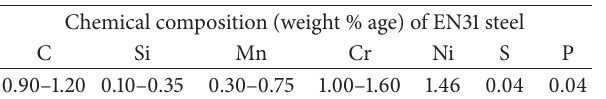
Table 3: Chemical composition (weight % age) of the EN-31 steel